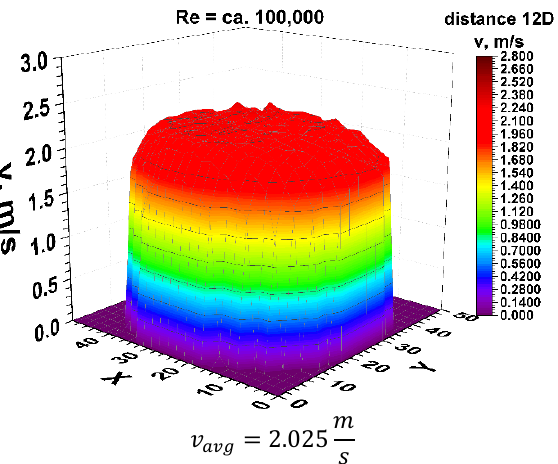
Figure 22. Velocity block at the distance 12D from the disturbance obtained by means of LDA measurements for Re ≅ 100,000.